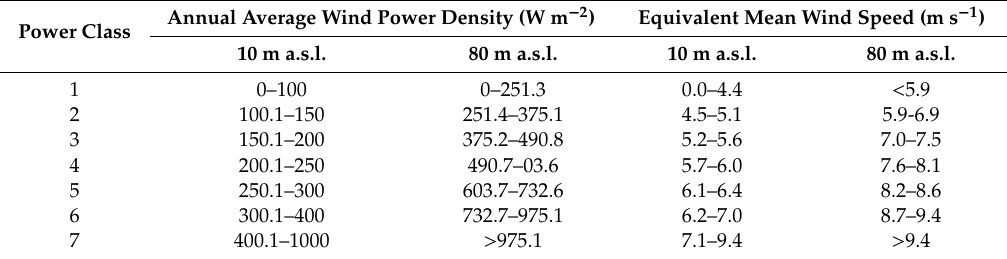
Table 1. Wind power classes and equivalent wind speed at 10 m a.s.l. and 80 m a.s.l. (derived from Salvaç ã o and Soares